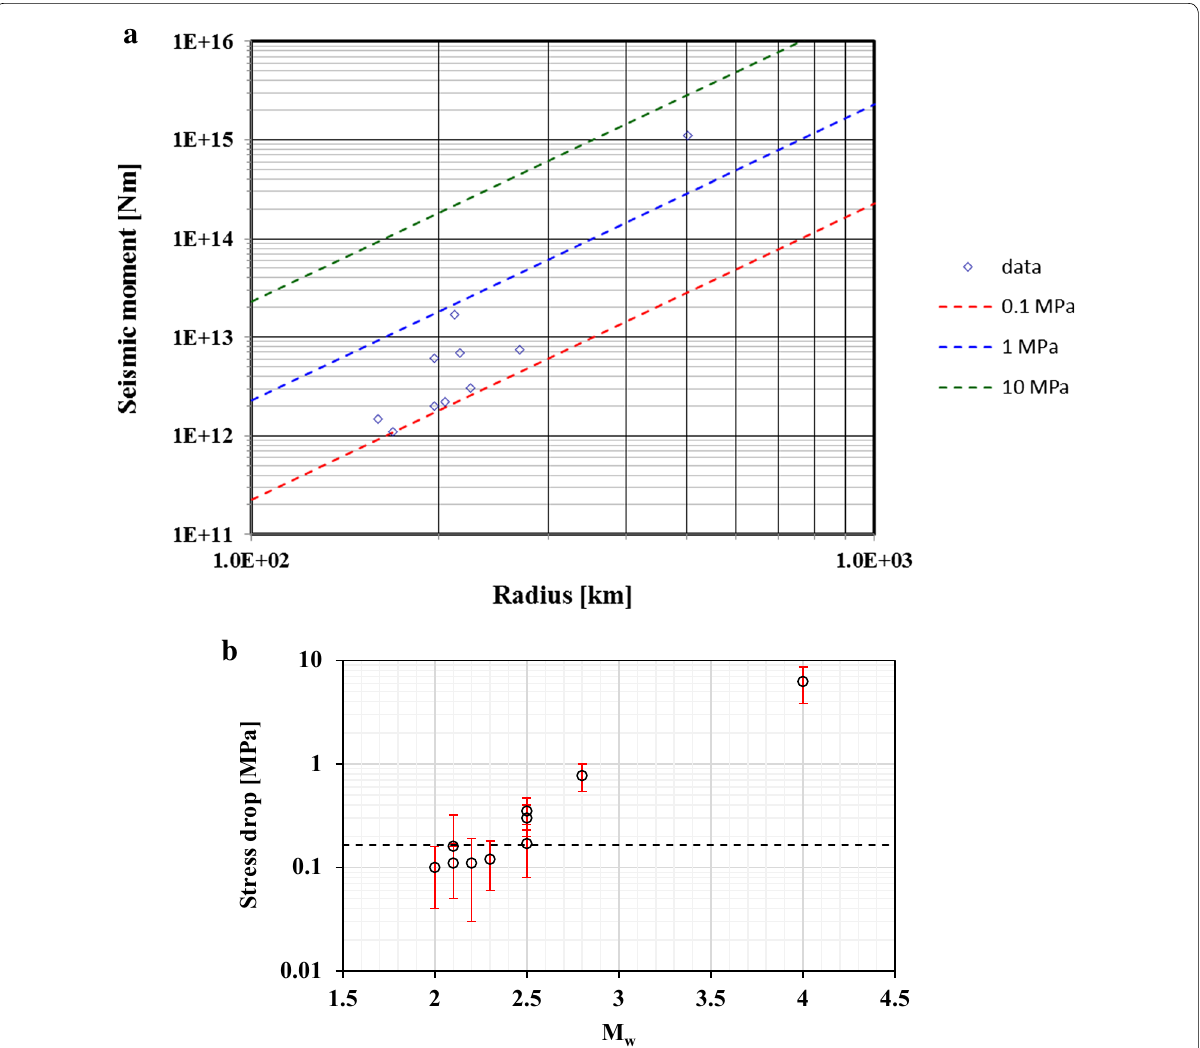
Fig. 9 Plot showing a the distribution of the seismic moments versus the fault radii with constant stress drops representing by solid lines for 0.1, 1.0, and 10 MPa, and b the distribution of stress drops as a function of moment magnitude (Mw). The dashed line represents the median of stress drop